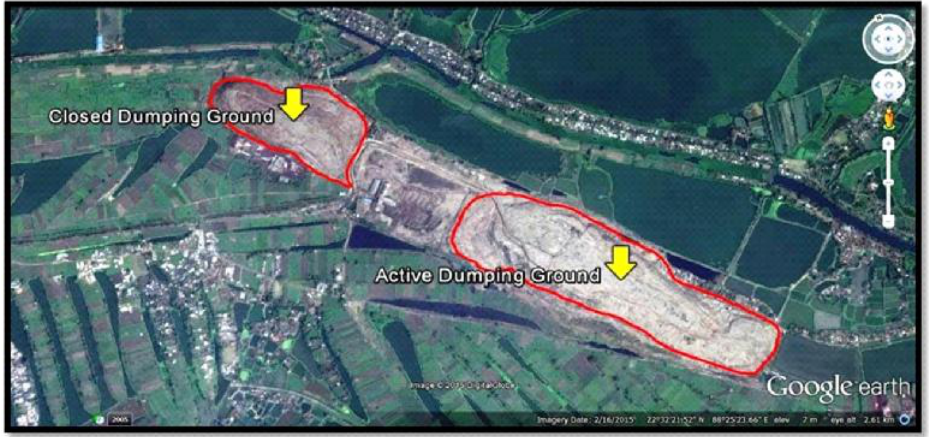
Fig. 1: Location of active and closed dumping ground at Dhapa uncontrolled landfill in Kolkata, India (Source: Google